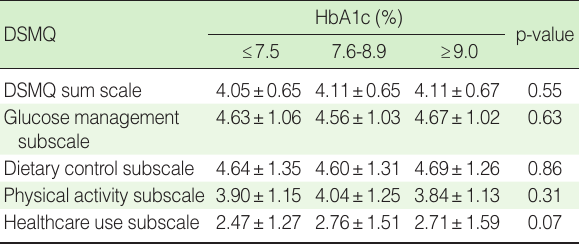
Values are presented as mean±standard deviation.